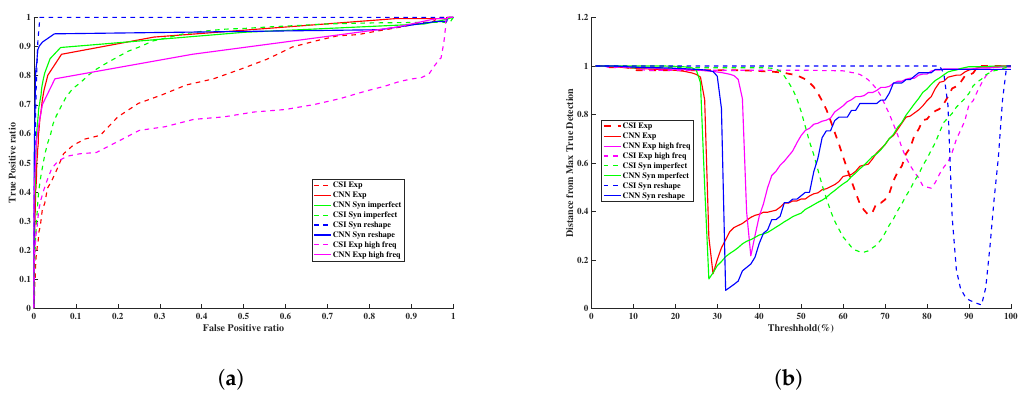
Figure 9. Detection performance based on the reconstructed outputs of CNN and CSI. ( a ) ROC curves derived from the reconstructed real part of the permittivity from CSI and CNN. ( b ) The DMTD. test cases are: synthetic: imperfect permittivity prior, and true breast phantom with elongated fibroglandular region. Experimental: using data within the frequency band and much higher than the training frequency band.